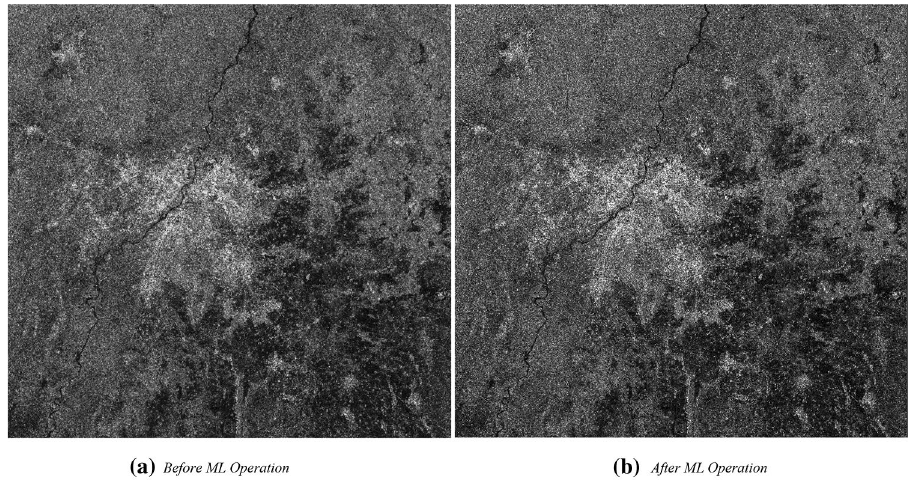
Figure 8. Effect of Speckle filter in VH polarisation.